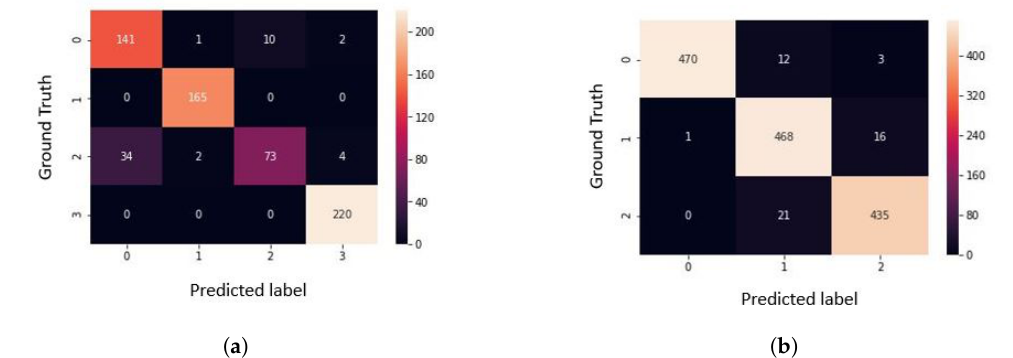
Figure 5. Confusion matrix of shallow VGG with RF ( a ) corn diseases ( b ) potato